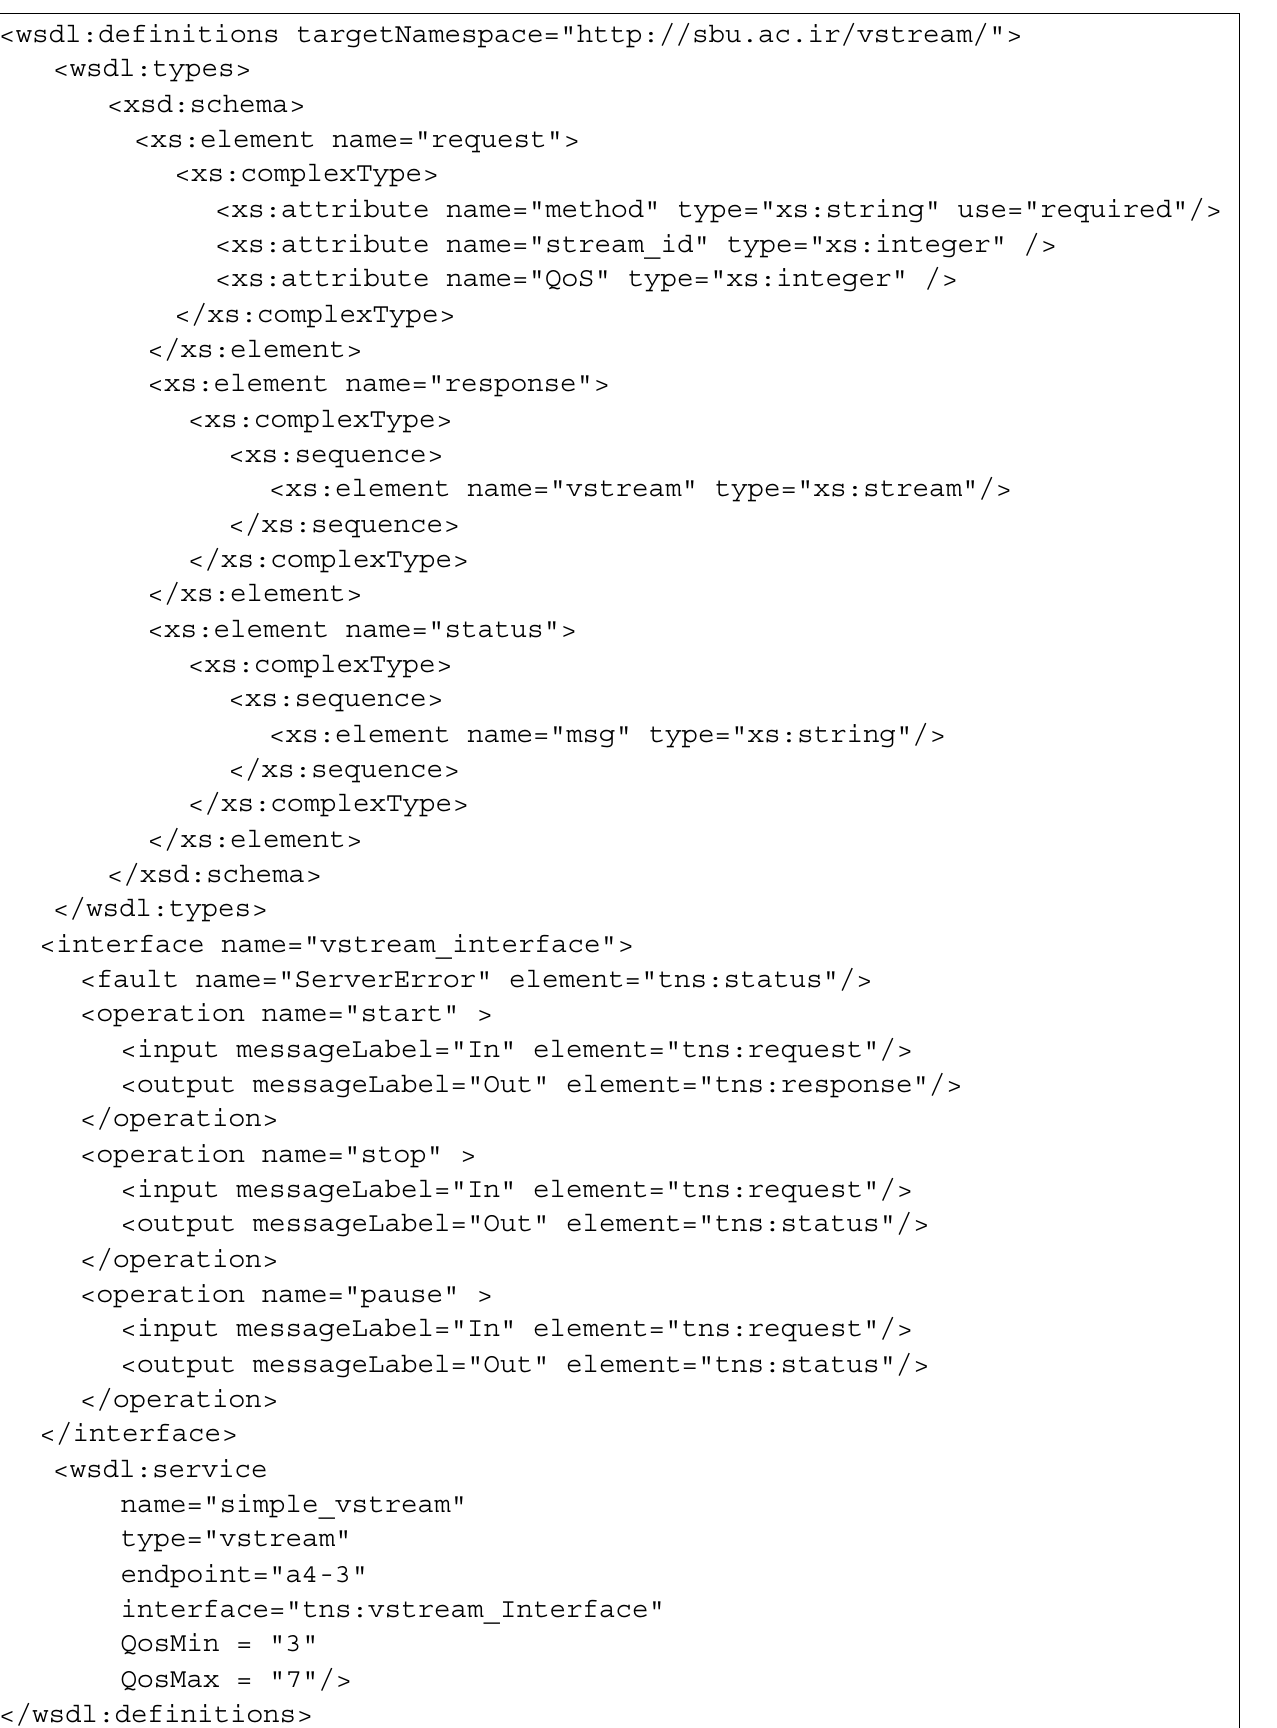
Figure 4. Service description for a simple video streaming